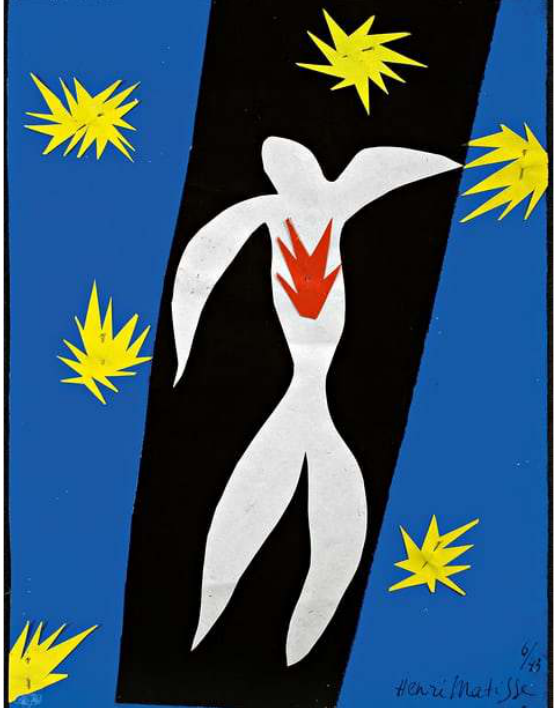
Figure 5. Henri Matisse, The Fall of Icarus